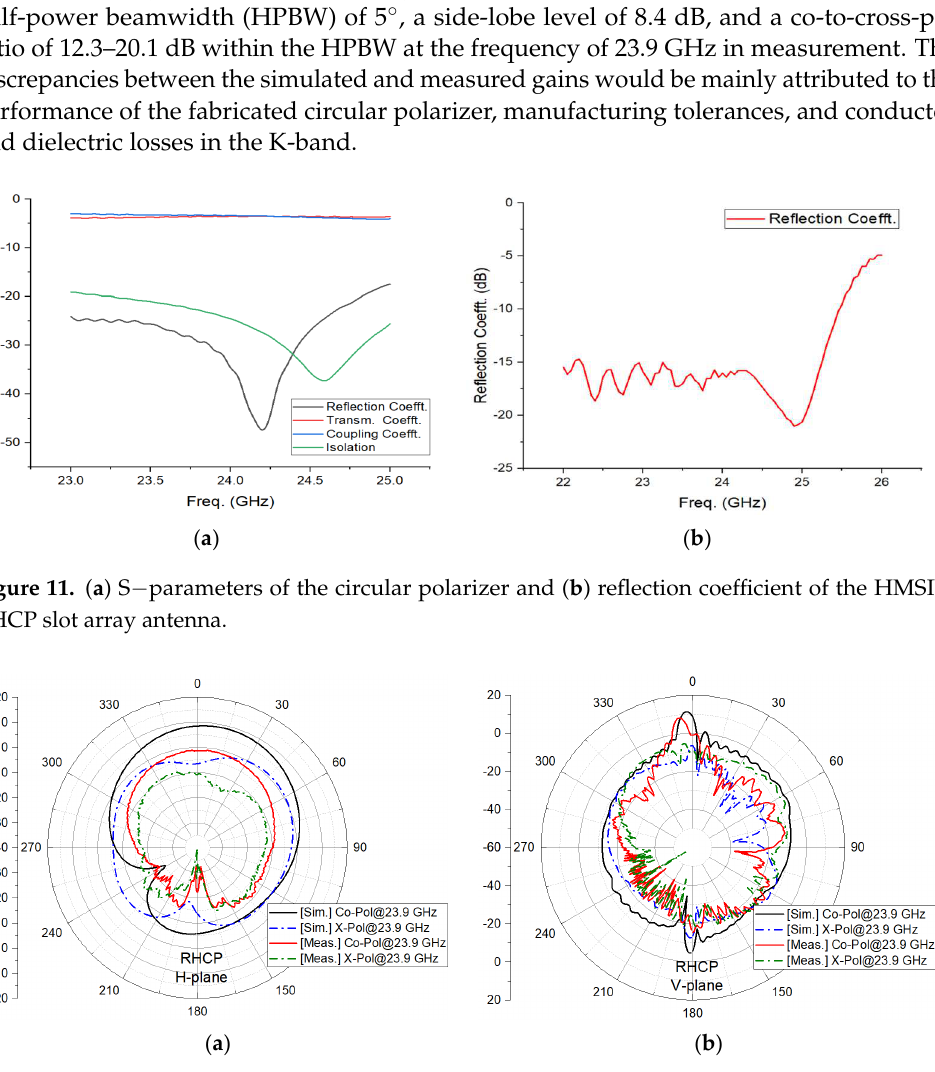
Figure 12. Simulated and measured results: ( a ) horizontal and ( b ) vertical radiation patterns of the HMSIW RHCP slot array antenna.